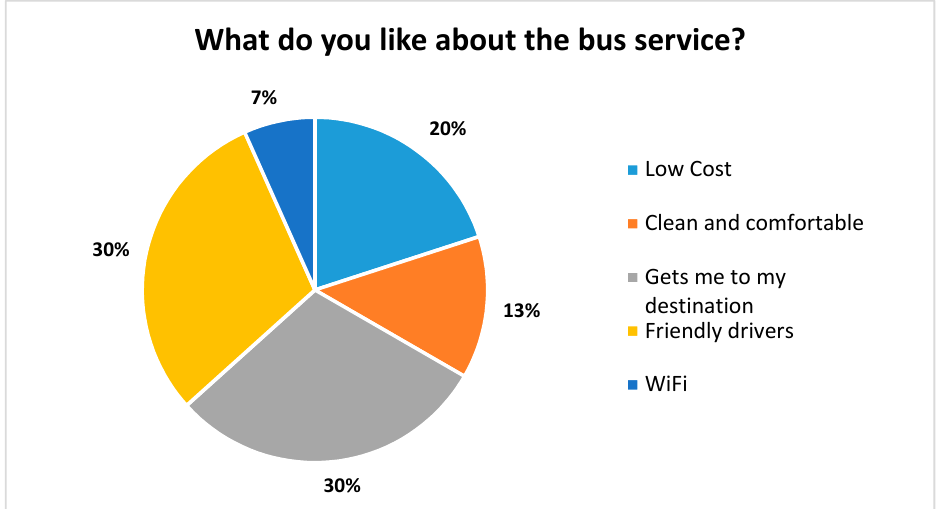
Figure 7. How do you get to your bus stop? Int. J. Environ. Res. Public Health 2017 , 14 , 629